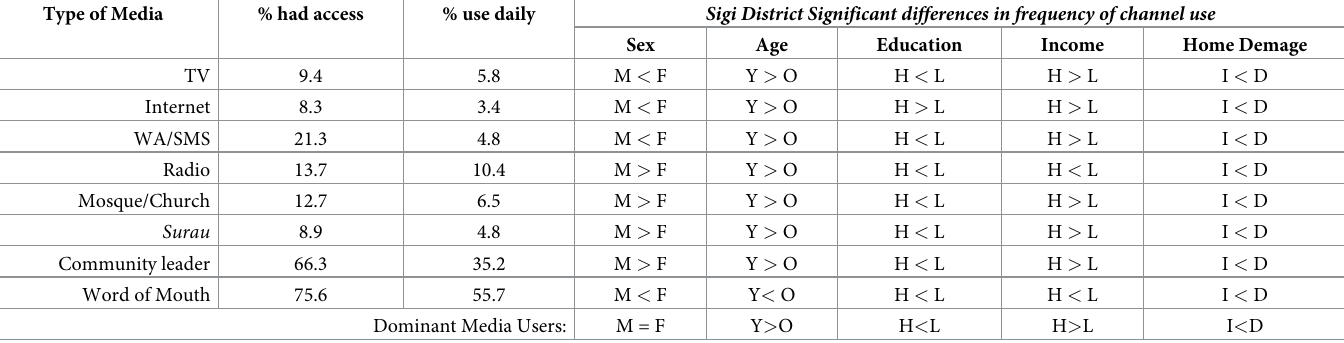
Table 2. Overall channel use patterns in Sigi